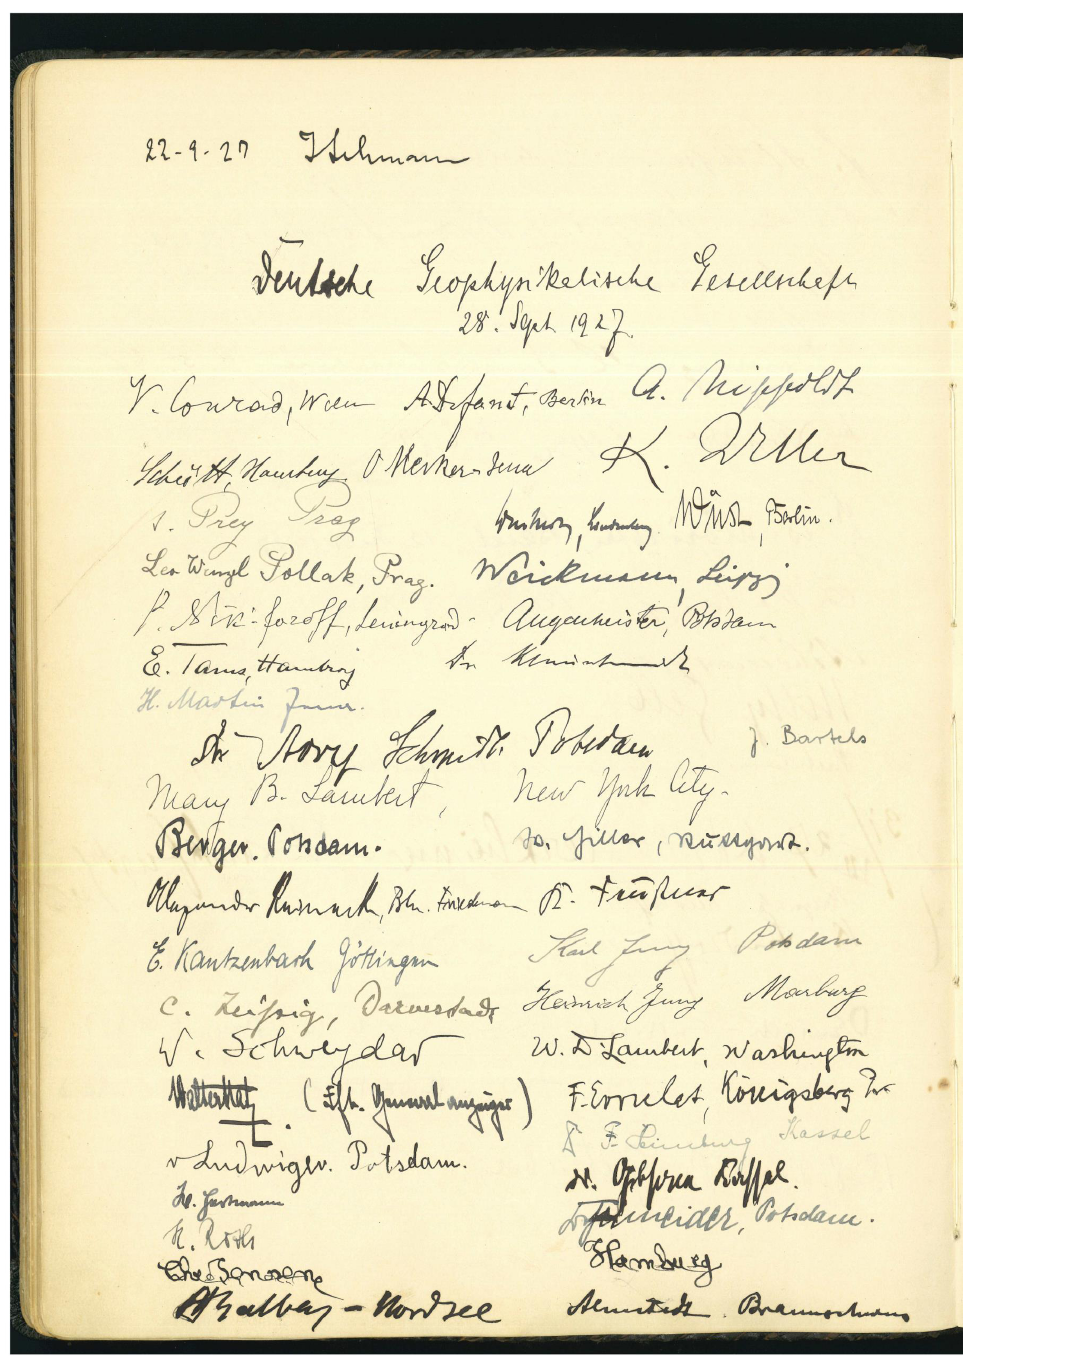
Figure 2. As an example of the international contacts of the DGG, this is a page from the guest book of the Taunus Observatory near Frankfurt am Main from 1927 (courtesy of the Seismology Group, Goethe University Frankfurt). This page not only documents the visit of the Danish seismologist Inge Lehmann (1888–1993; e.g., Emmerich and Schweitzer, 1988) on 22 September 1927, but also lists some of the participants at the Fifth DGG annual meeting in Frankfurt am Main, who visited the observatory as part of the conference program on the afternoon of 28 September 1927 (Schmidt, 1927). From this entry we know that at least five of the conference participants came from abroad (whether it was solely for the conference or another reason for staying in Germany is an open question): Victor Conrad (1876–1962; e.g., Hader, 1962) (Vienna, Austria), Walter Davis Lambert (1879–1968) (Washington DC, USA) here together with his sister Mary B. Lambert (New York City, USA), Pavel Mikhailovich Nikiforov (1884–1944) (Leningrad, Soviet Union), Leo Wenzel Pollak (1888–1964;